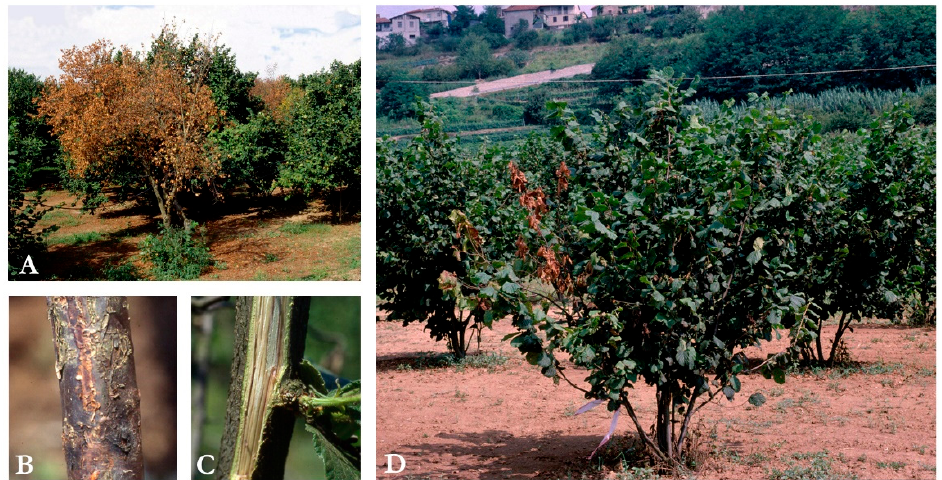
Figure 3. Disease symptoms incited by Pseudomonas spp.: sudden wilting in summer caused by P. avellanae ( A ); bark discoloration and swelling induced by P. avellanae on branch ( B ); longitudinal necrosis of wood caused by P. avellanae ( C ); twig dieback incited by P. syringae pv. coryli ( D ).